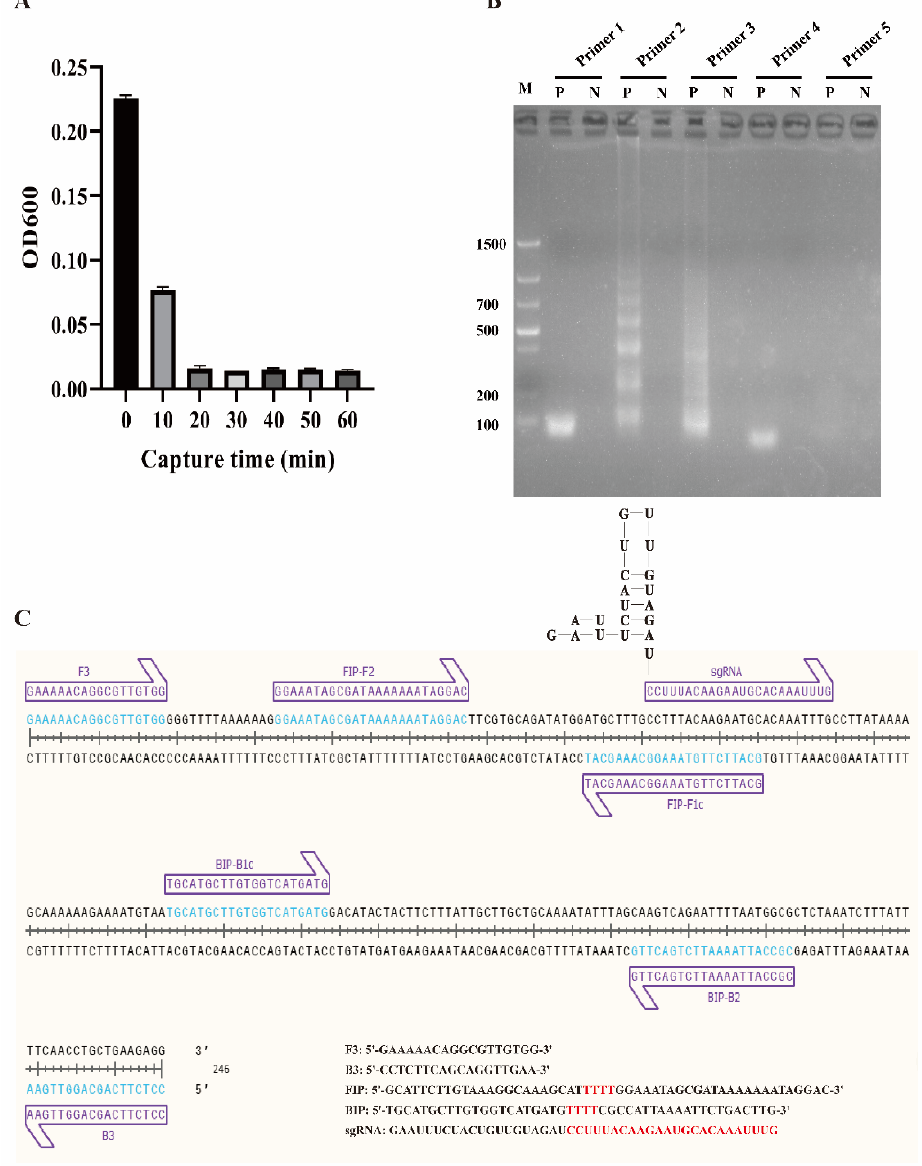
Figure 2. Construction of the ICB-LAMP reaction system. ( A ) Capture time evaluation of ICB. One milliliter of C. jejuni (8 × 10 3 CFU/mL) was mixed with 10 μ L of ICB, and the optical density (OD) in the supernatant was measured every 10 min. No significant difference was observed after 20 min of incubation. ( B ) LAMP primer selection. Five groups of LAMP primers based on the hipO gene were obtained and used in the LAMP reaction, and primer 2 had the best amplification effect. ( C ) LAMP primers and sgRNA binding sites.